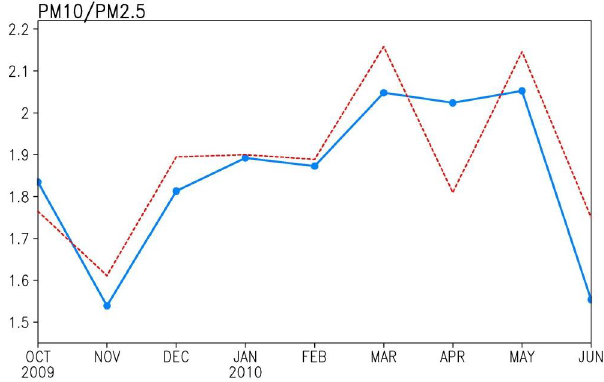
Fig. 4. Ratio of monthly PM 10 mass density to monthly PM 2 . 5 Figure 4. Ratio of monthly PM10 mass density to monthly PM2.5 mass density at Gosan. mass density at Gosan. Monthly values are obtained from arithmetic Monthly values are obtained from arithmetic mean (blue lines) and median (red lines). mean (blue lines) and median (red